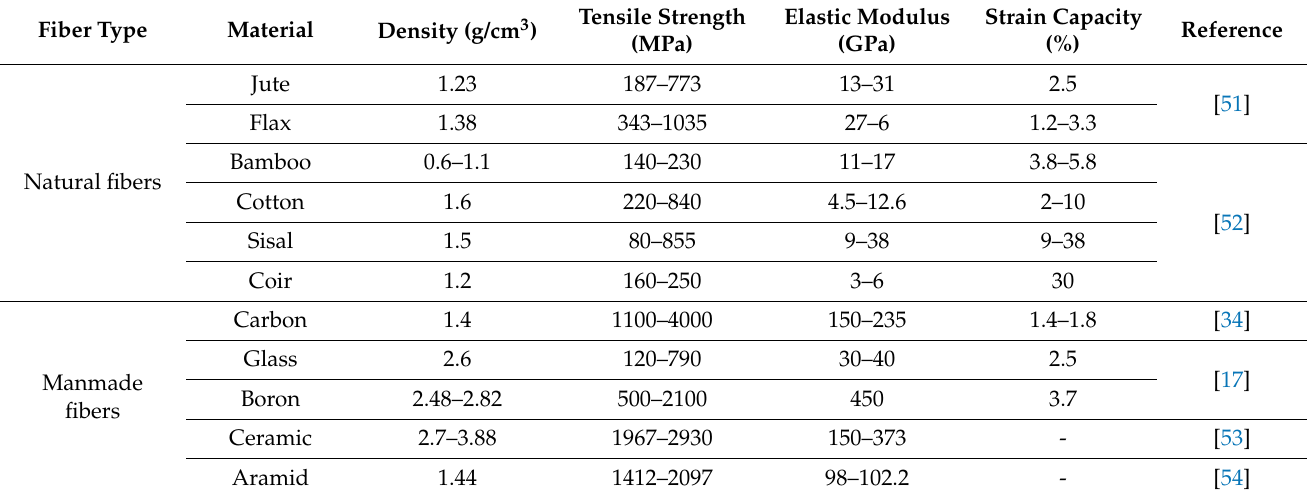
Table 1. Types of fiber and its mechanical